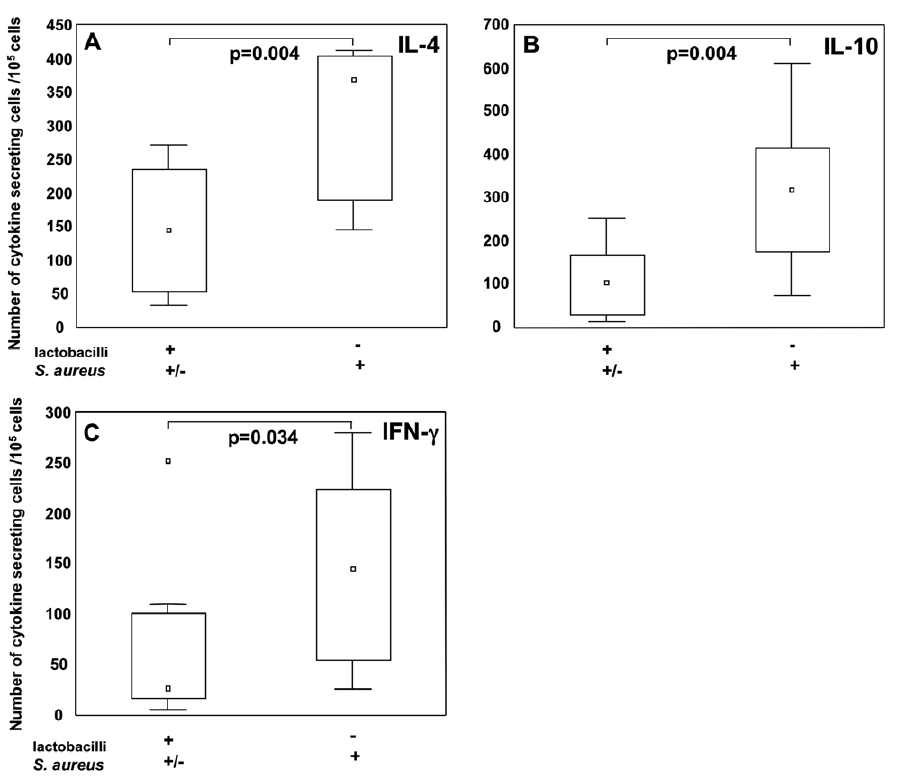
Figure 4. Lactobacilli and S.aureus co-colonization at 2 weeks of age in relation to cytokine secreting cells, after invitro PHA stimulation at age two. Infants colonized with only S. aureus (n=12) or infants colonized with lactobacilli ( + / 2 S. aureus ) (n=9) with at 2 weeks of age in relation to (A) IL-4 2 , (B) IL-10 2 , and (C) IFN- c -producing cells after PHA stimulation. Boxes cover 25 th to 75 th percentile and the central square being the median value. Whiskers extend to non-outlier maximum and minimum and squares represents outliers.